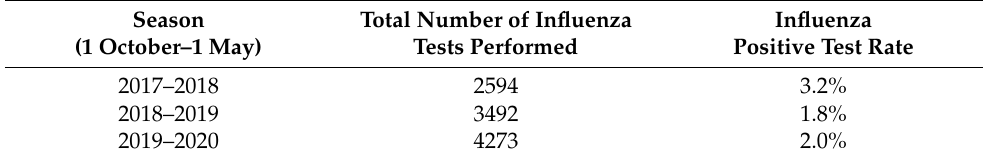
Table 3. Total Volume of Influenza Tests Performed with the Corresponding Positivity